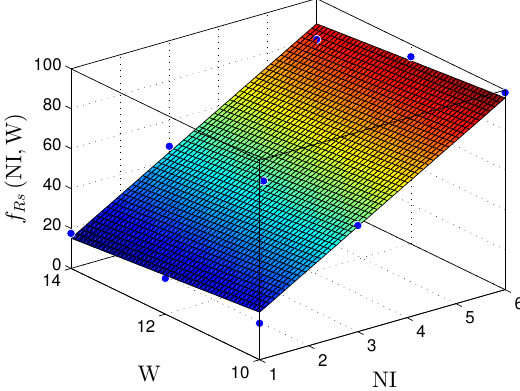
( NI , W ) , found to estimate the number of registers, R s , as a function of the Figure 23. Plane, f R s number of implementations, NI, and the number of bits in fractional part W , for MLP-based prediction techniques.